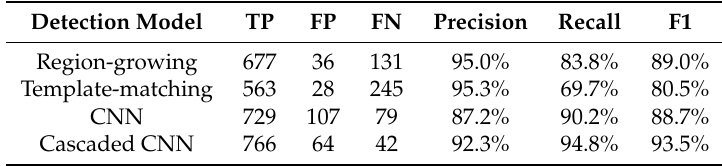
Table 1. The comparisons of Test Area